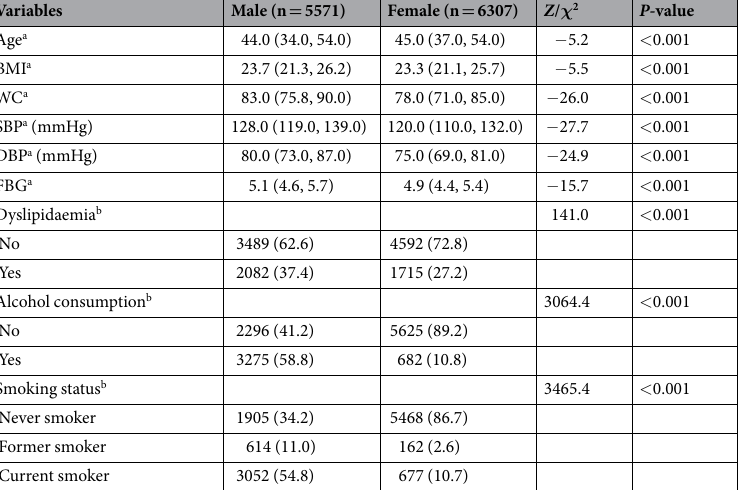
Table 1. Descriptive characteristics of participants by gender. a Presented as the median (inter-quartile range); b presented as n (%). BMI: body mass index; WC: waist circumference; SBP: systolic blood pressure; DBP: diastolic blood pressure; and FBG: fasting blood glucose.